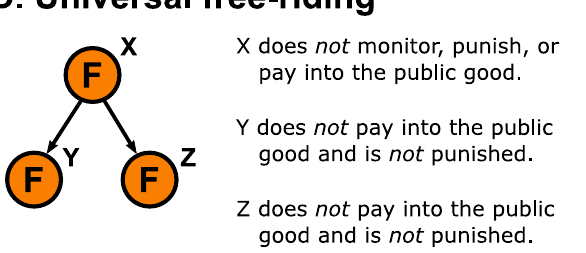
Figure 3. An example motif, with one individual responsible for monitoring and punishing the other two, having different mixes of contributors and free-riders. Nodes labeled ( C ) (yellow) represent contributors and nodes labeled ( F ) (orange) represent free-riders. In ( A ) contributing is universal. Individual X pays 2/ m to monitor individuals Y and Z and contributes c t − 2 / m , to the public good. Individuals Y and Z each contribute c t to the public good. In ( B ) individual X pays 2/ m to monitor individuals Y and Z, pays c p to punish individual Y, and contributes c t − 2 / m − c p to the public good. Individual Z contributes c t to the public good. Individual Y is punished by Individual X which costs Individual Y pc p . In ( C ) Individual Z contributes c t to the public good. Individuals X and Y contribute nothing and receive no punishment. In ( D ) all individuals are free-riders who contribute nothing and do not receive any